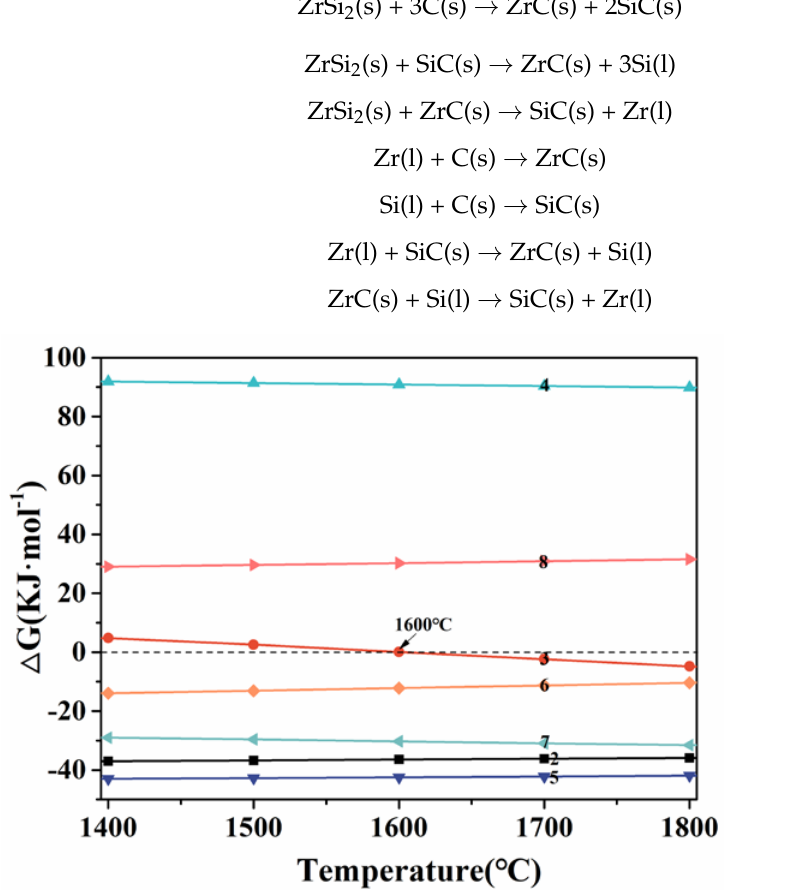
Figure 4. The Gibbs free energy change for reactions (4)–(10) as a function of